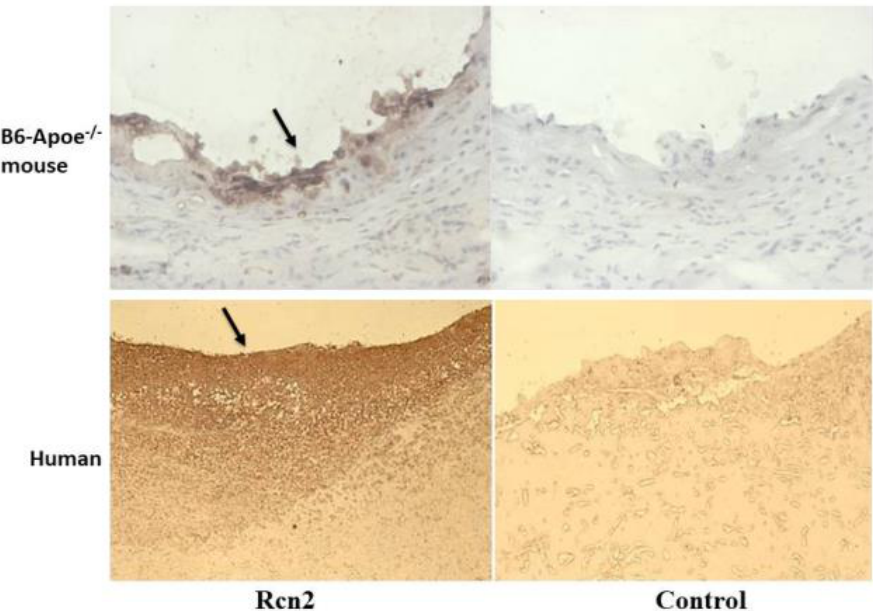
Figure 2. Immunohistochemical detection of RCN2 expression in atherosclerotic lesions of a mouse